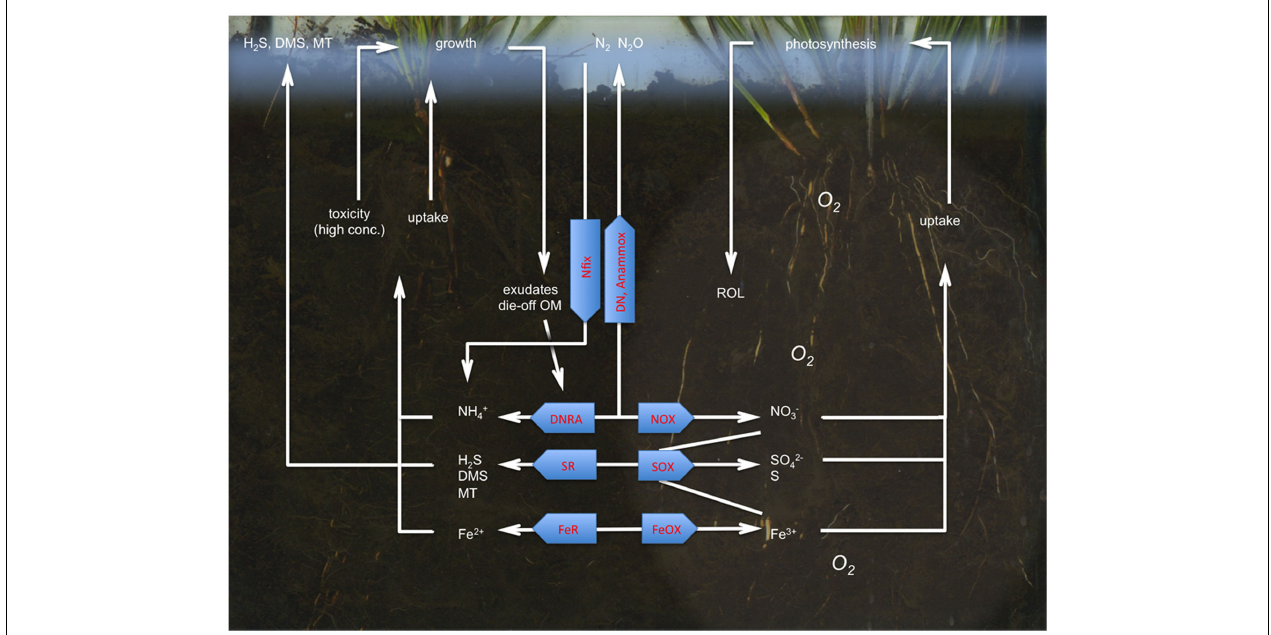
FIGURE 4 | Microbe–plant interactions in the biogeochemistry of N, S, and Fe in wetland soils. Losses of volatile N and S compounds to the atmosphere also occur through plant tissues, which has not been depicted here. See text for further explanation. DNRA, dissimilatory nitrate reduction to